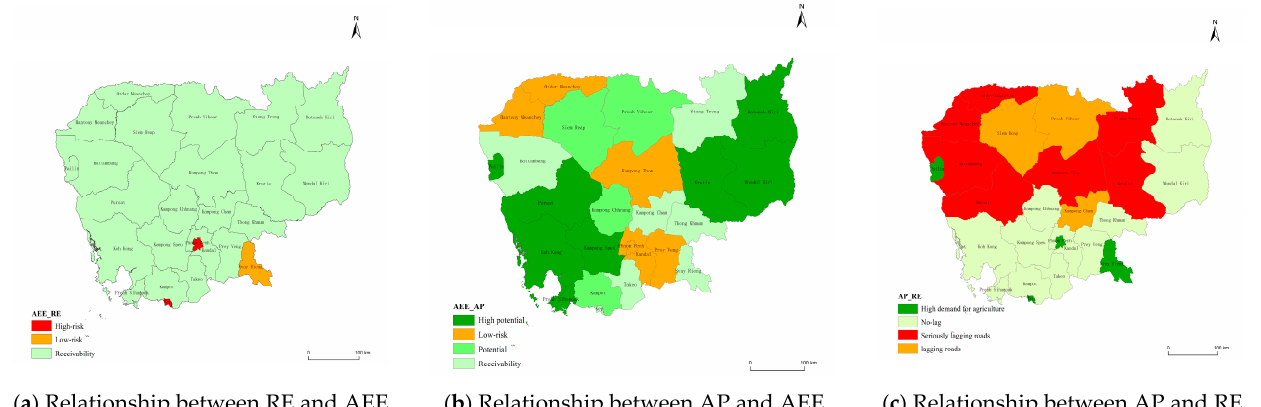
Figure 6. Relationship among agricultural production, road environment, and agricultural eco- environment in Cambodia. Table 6. Relationship between agriculture, roads, and agricultural eco-environment systems in